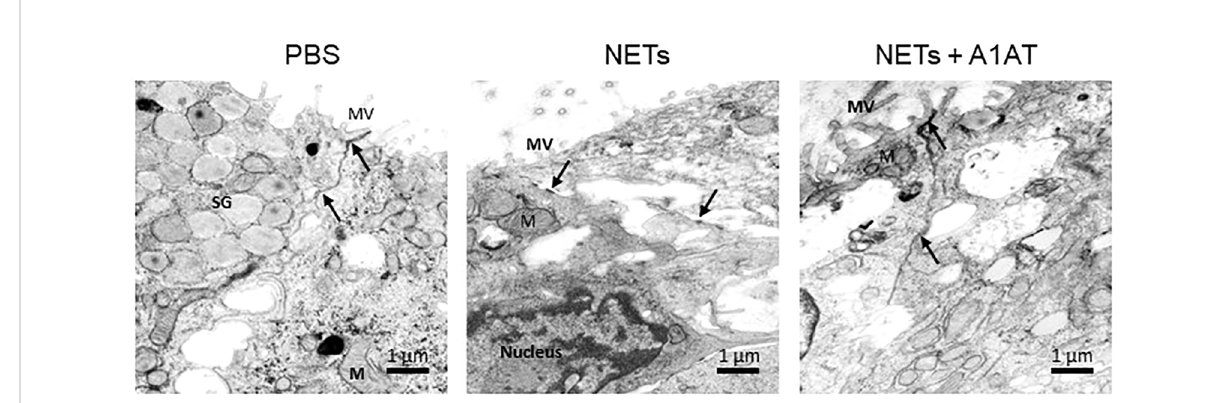
FIGURE 6 Alpha-1 antitrypsin preserves epithelial cell junction integrity disrupted by NETs. Representative images from transmission electron microscopy of HBE exposed to PBS, 5µg/ml NETs, NETs + A1AT or A1AT for 18 h. NET exposure resulted in partial disruption of epithelial tight junctions. A1AT helped maintain tight junctions in HBE exposed to NETs. (M=mitochondria, MV=microvilli, SG=secretory granules in a goblet cell, ( ! ) =cell junction, experiments=1, HBE donors=1, NET donors=1).